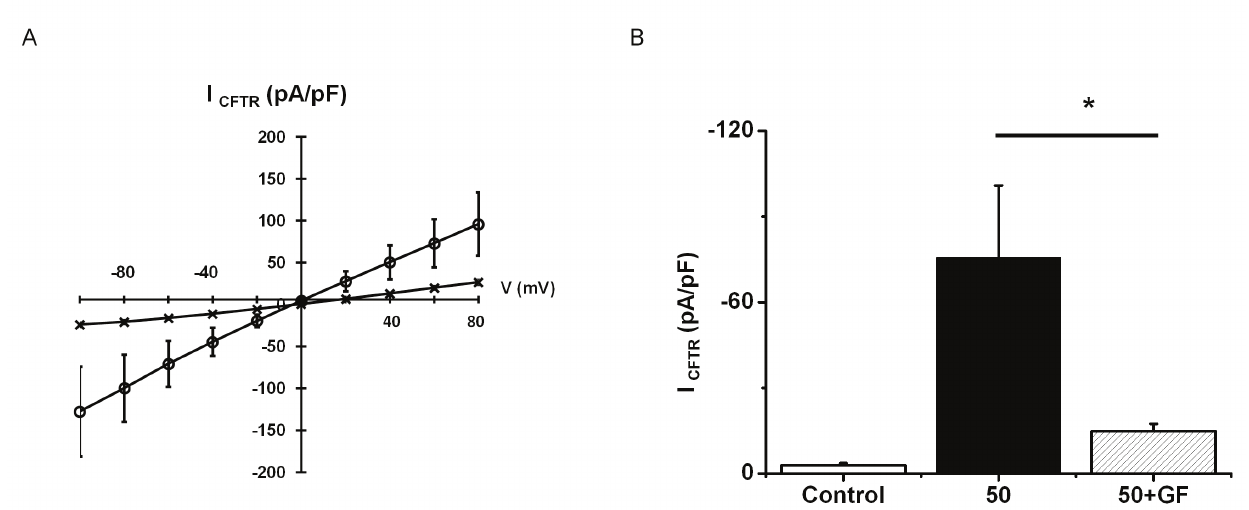
Figure 9. Stimulation of F508del-CFTR activity by TNF α is blocked by PKC inhibitor (GF109203X). Whole cell Cl - currents recorded in HeLa cells expressing F508del-CFTR by patch-clamp experiments. * indicates significant results. A . Mean CFTR-related current-voltage relationships. Current densities normalized to cell capacitance (pA/pF) were measured in the presence of 50 ng/ml TNF α ( O ); on cells treated for 30 min by 5µM GF109203X in the presence of TNF α ( X ). B . Mean CFTR current amplitudes recorded at -60 mV and normalized to cell capacitance in untreated cells (control; mean + SEM; n=8), in cells treated for 10 minutes by TNF α (50; means + SEM, n=8) and in cells treated by 5 µM GF109203X for 30min and for 10 minutes by TNF α (50+GF; means + SEM, n=6). Statistics: non-parametric unpaired Student’s t test between (50) and (50 + GF),